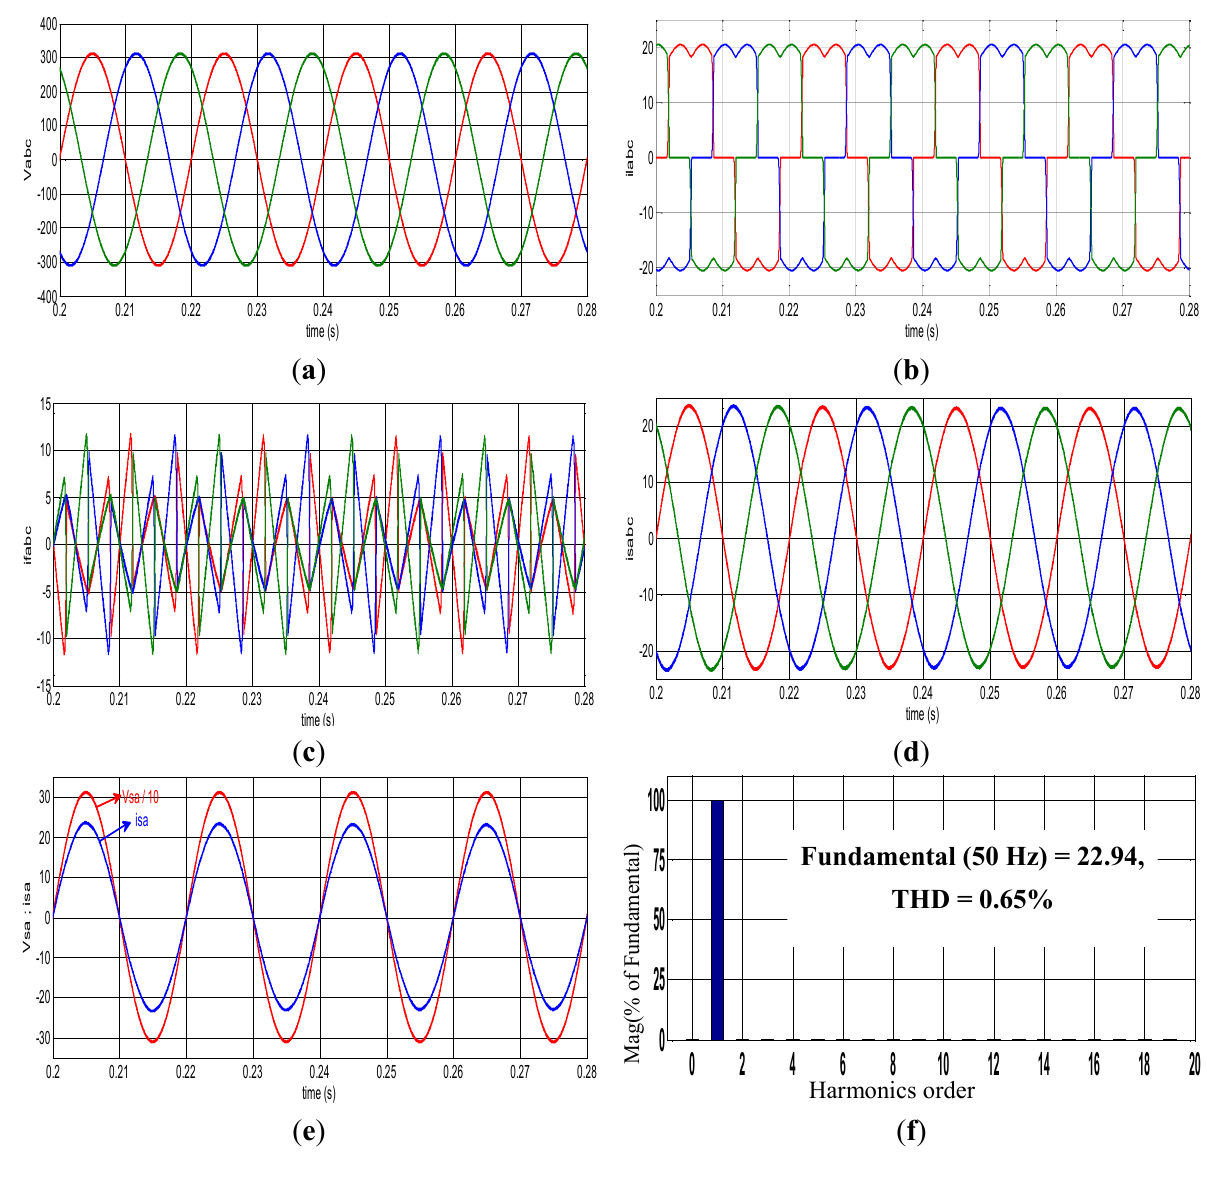
Figure 12. Simulation results for balanced sinusoidal grid voltage: ( a ) three-phase line voltages; ( b ) three-phase load currents; ( c ) three-phase filter currents; ( d ) three-phase line currents; ( e ) line voltage and current, phase-a; ( f ) frequency spectrum of line current, phase-a.